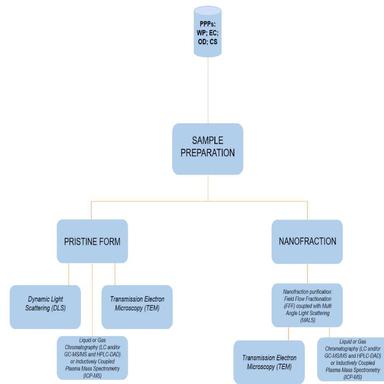
Methodological approach for the physico-chemical characterization of Plant Protection Products (PPPs).